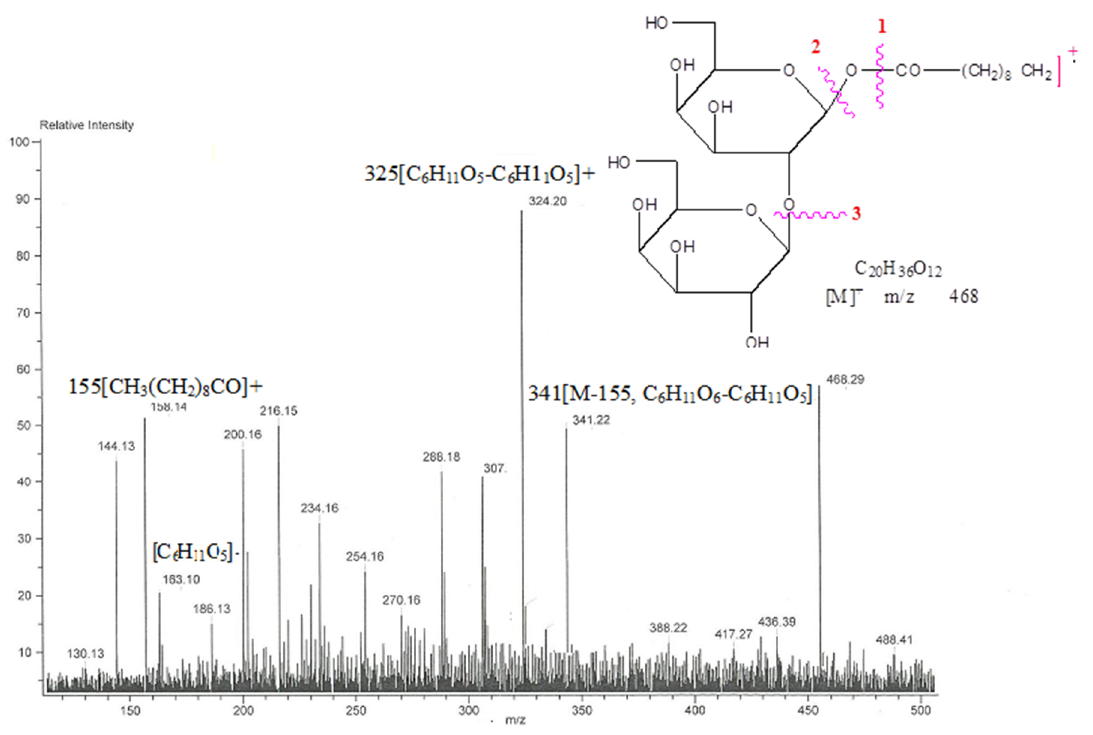
Figure 7. The diagnostic MS/MS fragmentation at m/z 792 full ESI-MS scan of the isolated compound